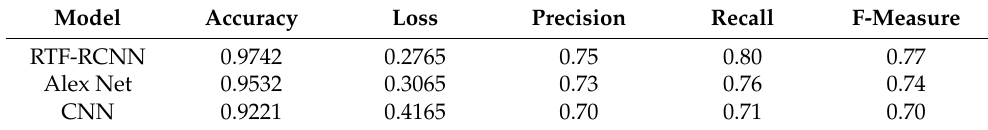
Table 12. The comparison of accuracy, loss, precision, recall and F-measure.